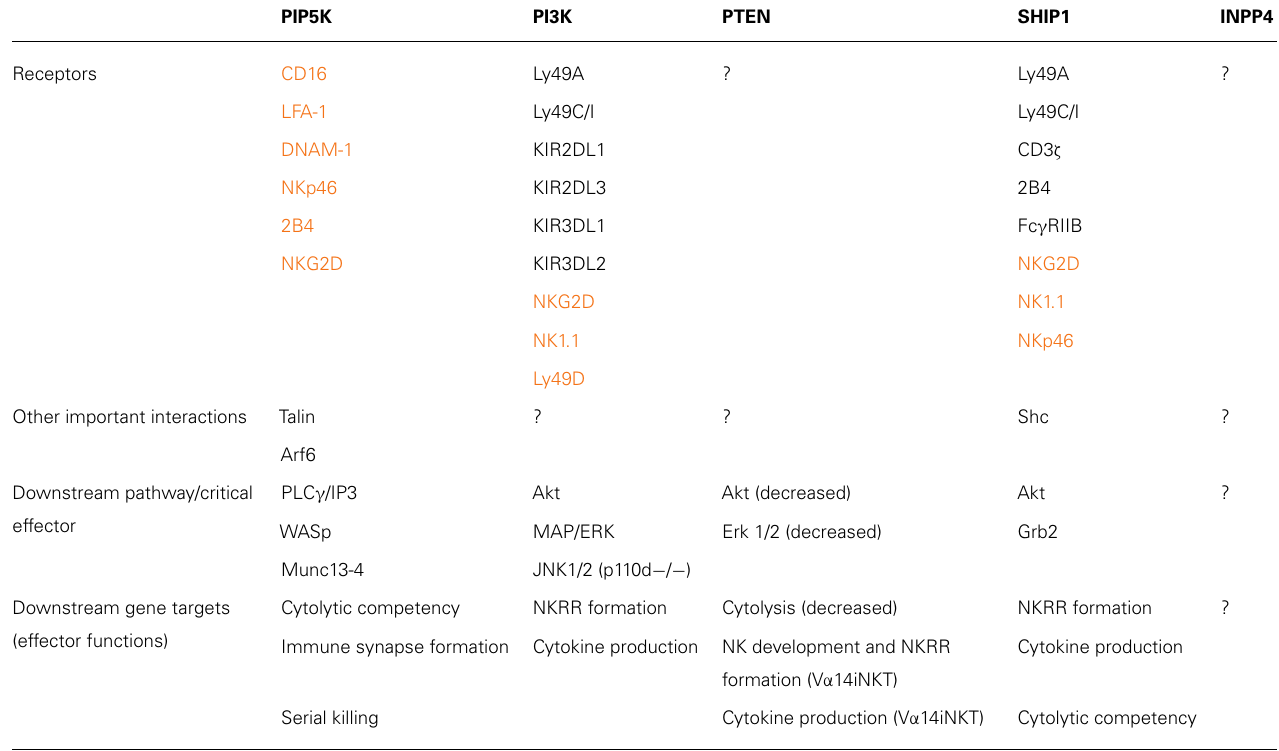
FIGURE 1 | Inositol phospholipid family members allow for recruitment of proteins with indicated binding domains. Modification of the inositol phospholipids by the indicated enzymes allow for either the attenuation or promotion of signaling pathways that determine NK cell development, function, survival, and/or trafficking in the host. PIP5K PLC, phospholipase C; DAG, diacylglycerol; PIP5K, phosphatidylinositol